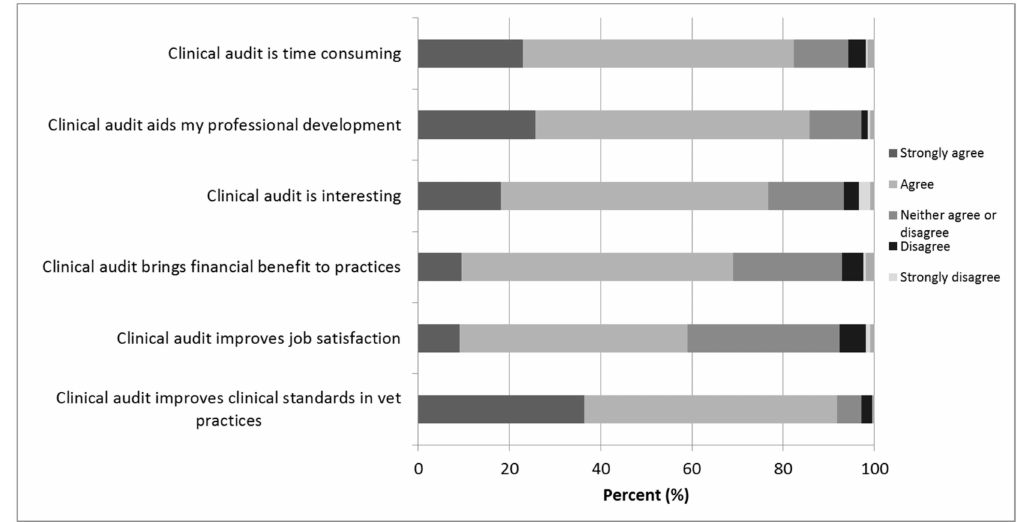
Figure 3. Attitudes towards clinical audit from veterinary surgeons that had heard of clinical